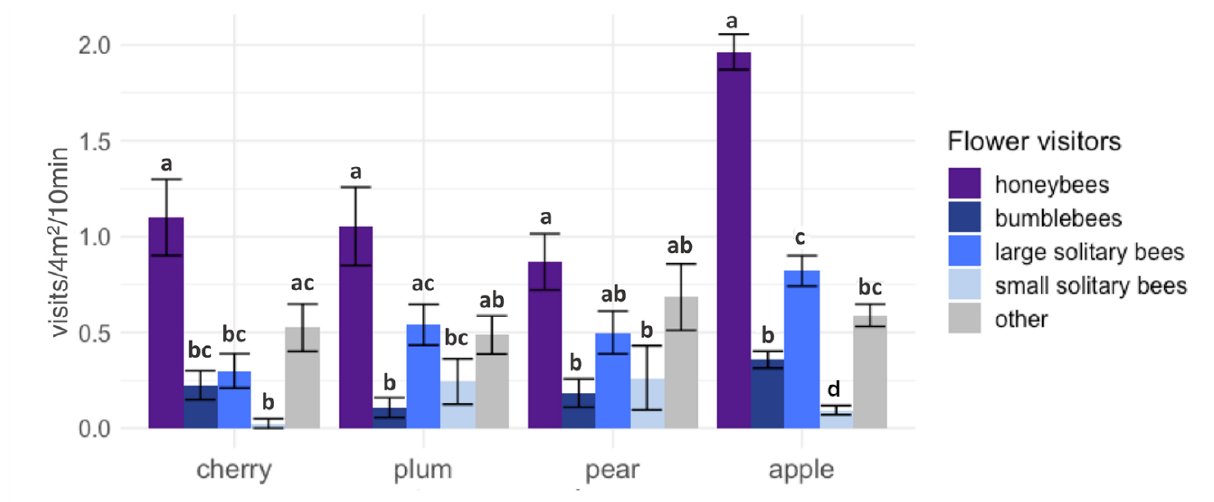
Figure 8. Abundance of honeybees, bumblebees, large solitary bees, small solitary bees and other insects on cherry, plum, pear and apple flowers per 10 min observation period within a standardised 4 m 2 frame. Whiskers display the mean ± standard error. Bars with different letters are significantly different according to pairwise comparisons using Dun n’s test at P  0.025. Total insect abundance N = 999, total observation time =